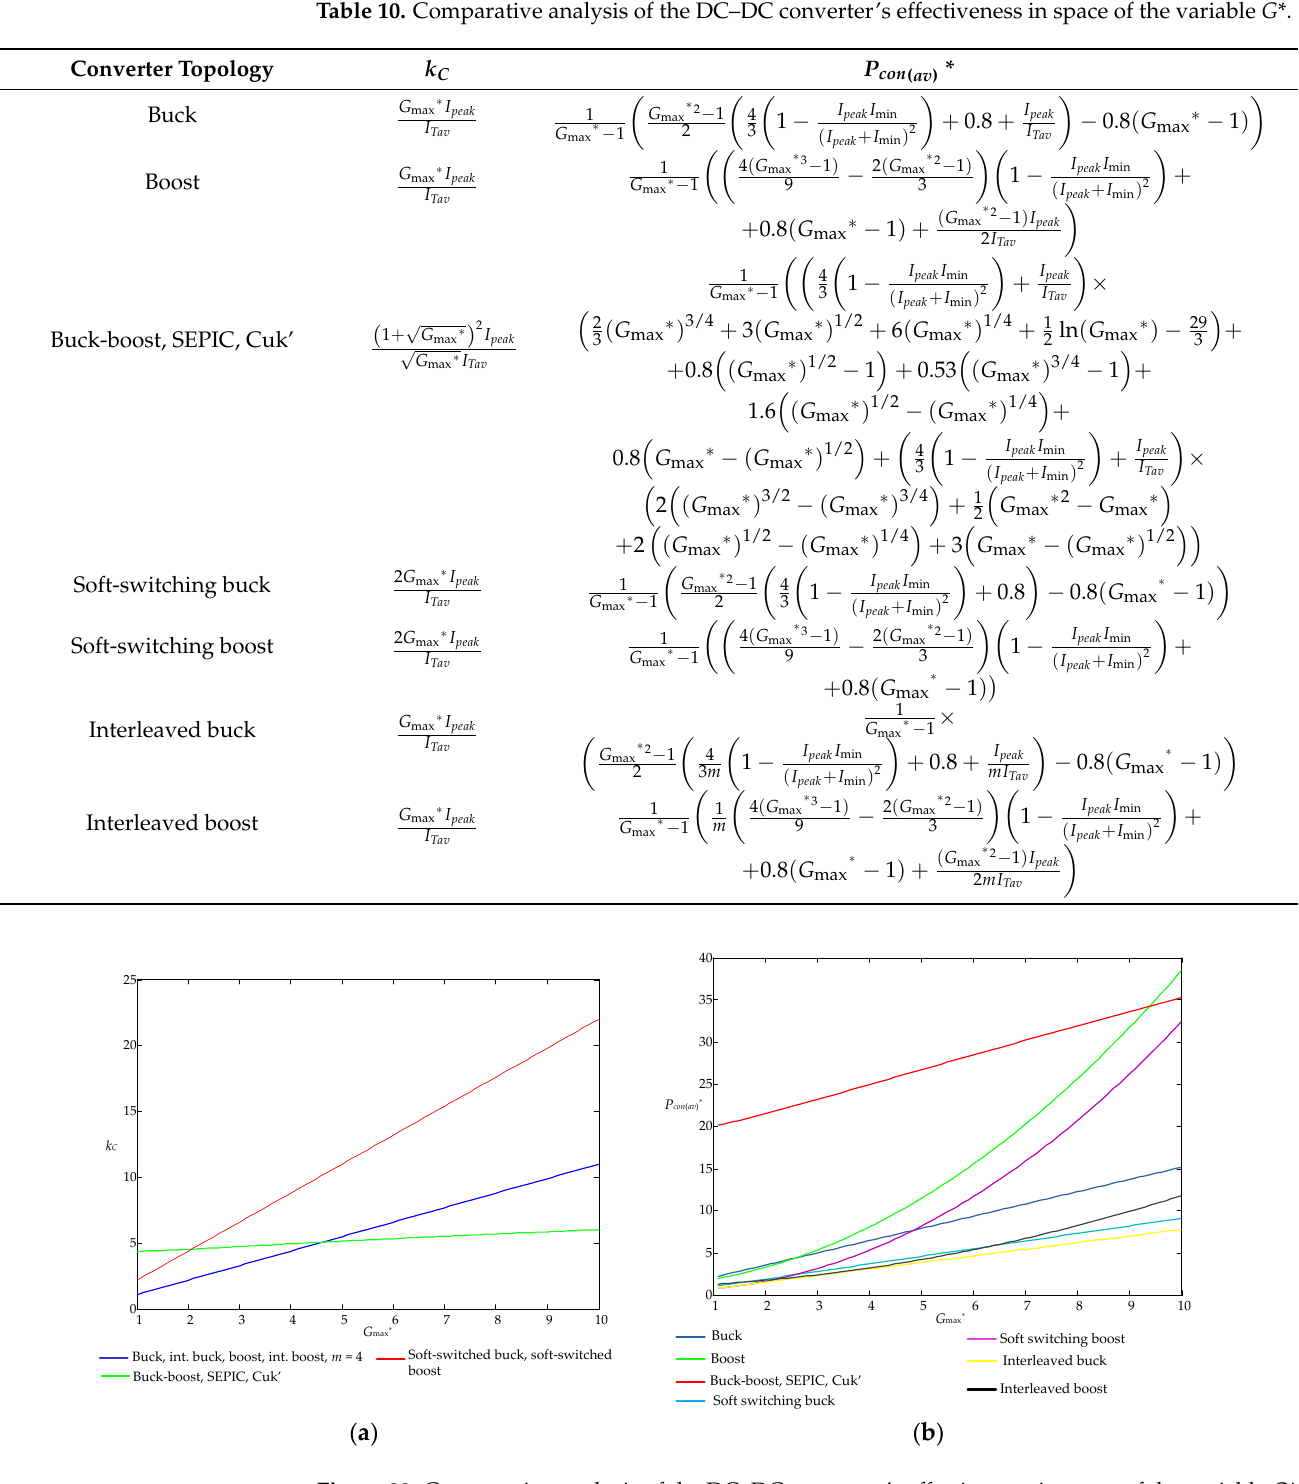
Figure 22. Comparative analysis of the DC–DC converter’s effectiveness in space of the variable G *: ( a ) cost factor k C ; ( b ) normalized mean power loss P con ( av ) * .